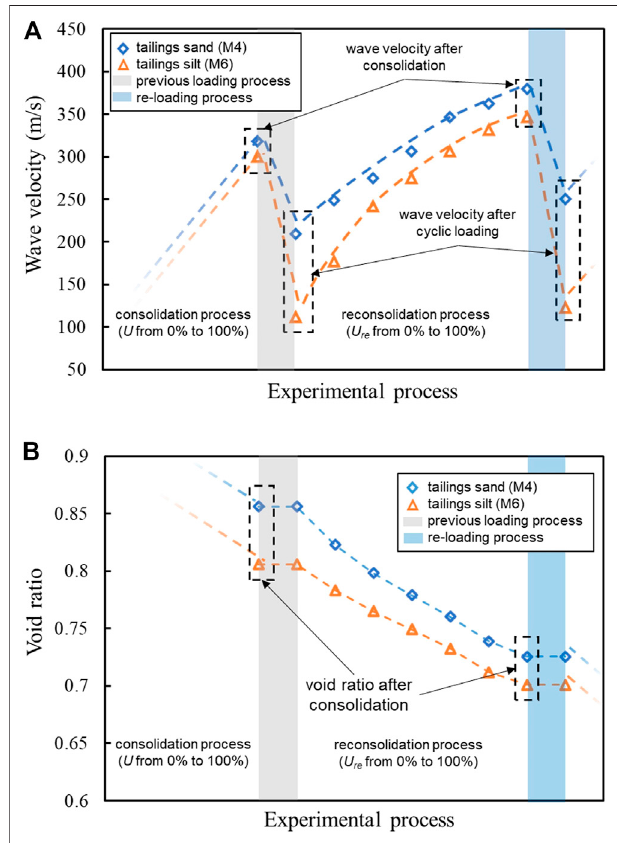
FIGURE 10 | Changes of shear wave velocity and void ratio of tailing sand (M4) and tailing silt (M6) during the test: (A) wave velocity and (B) void